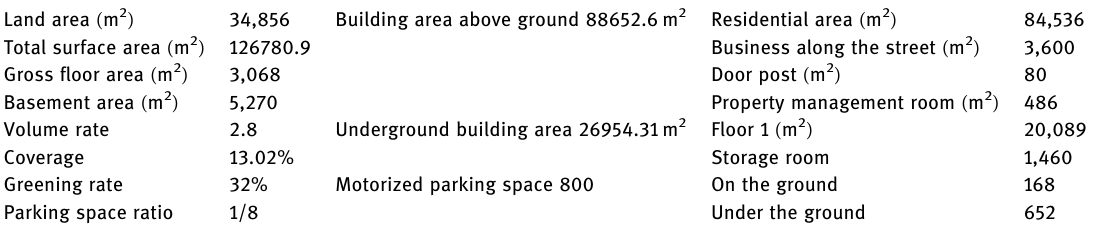
Table 1: Area indicators of construction